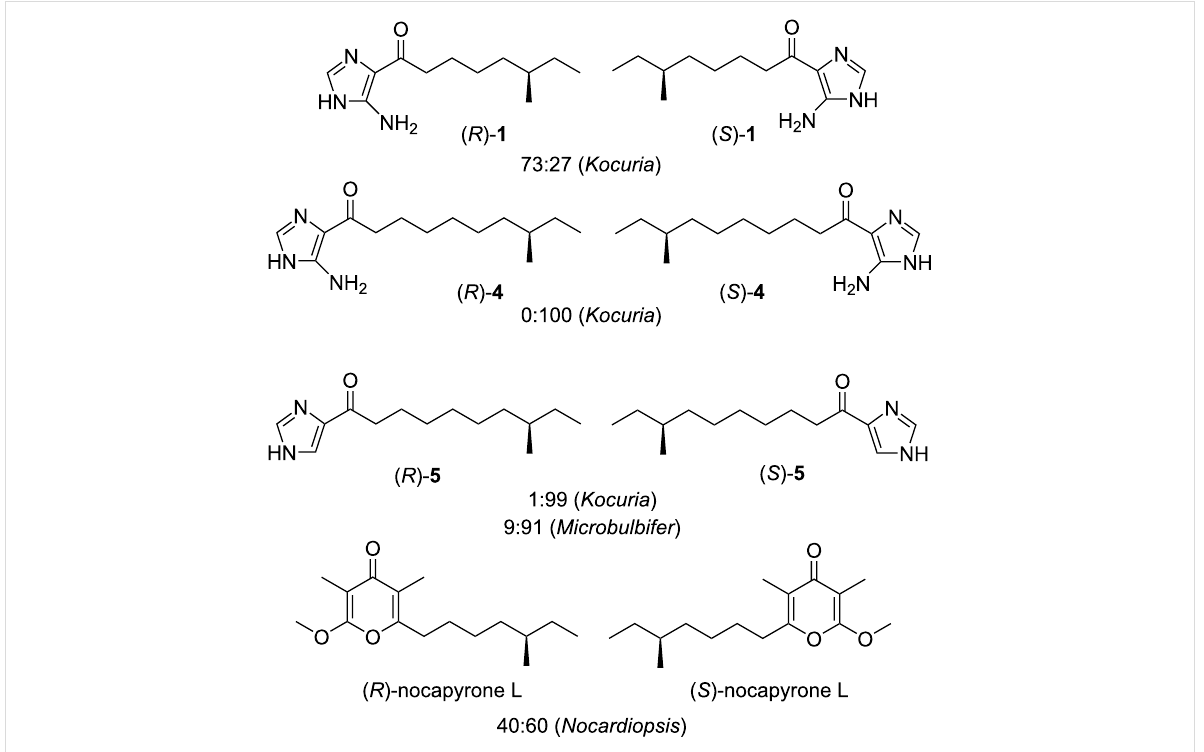
Figure 5: Stereochemical diversity of the anteiso-chain chirality in microbial